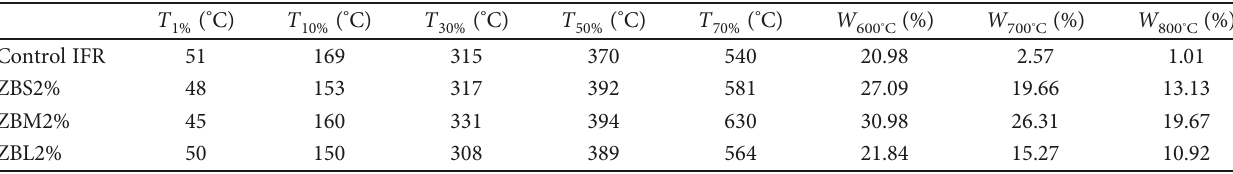
Table 3: TGA data of IFR/ZB coatings (under air).